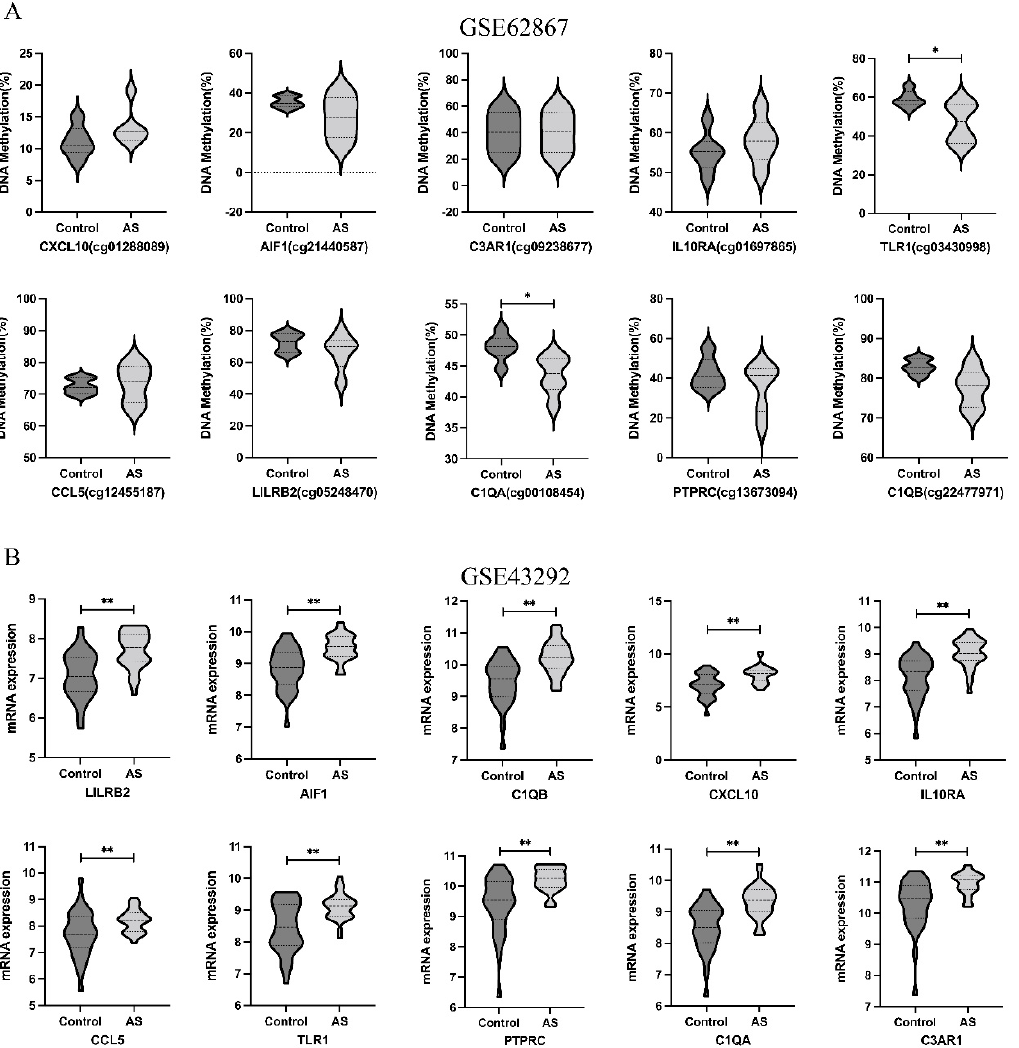
Figure 12. Validation of expression levels and methylation levels of hypo-up genes in AS in gene expression dataset (GSE43292) and DNA methylation dataset (GSE62867). ( A ) The methylation levels of hypo-up genes in GSE62867. ( B ) The expression levels of hypo-up genes in GSE43292. The comparison between the two groups with the paired t-test. GraphPad Prism software was used in statistical analysis. A p -value < 0.05 was considered statistically significant. * p < 0.05; ** p < 0.01.